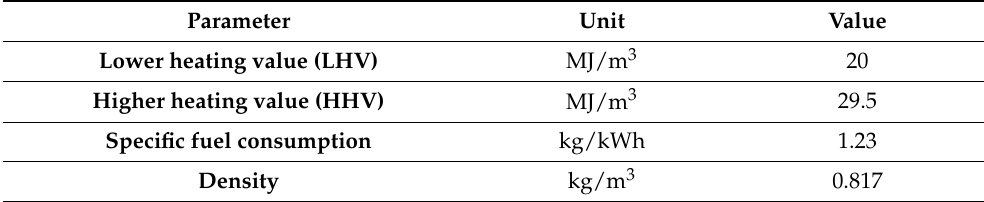
Table 4. Physicochemical properties of biogases. Parameter